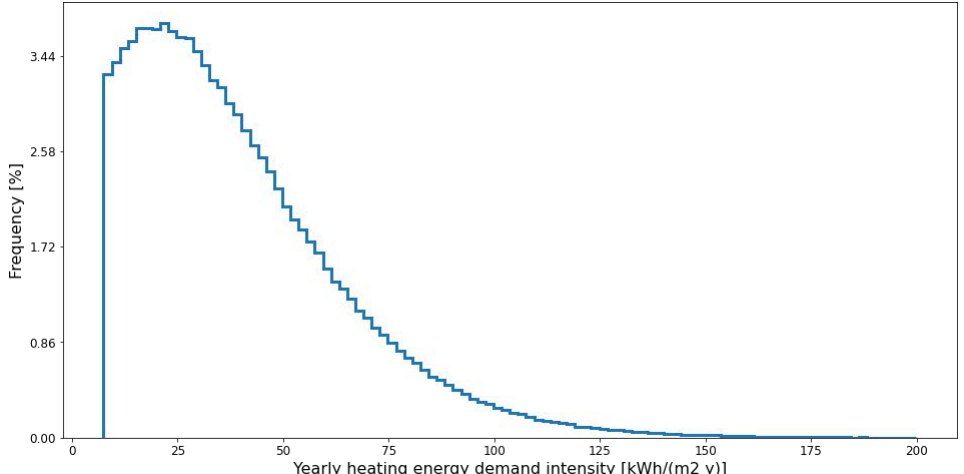
Figure 1. Frequency of occurrence for values of yearly heating energy demand